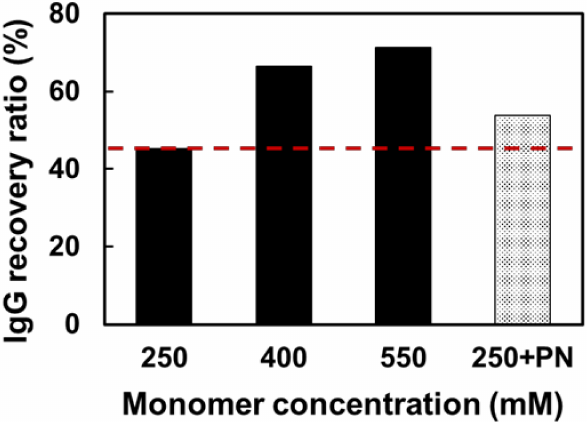
Figure 7. Effects of monomer concentration on IgG recovery ratio (PN: free PNIPAAm).